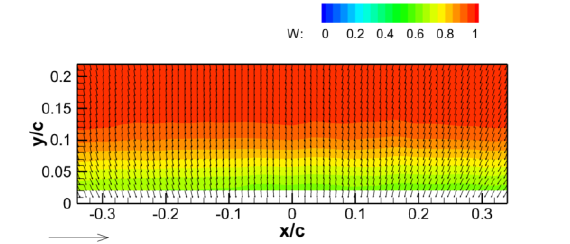
Fig. 3. Mean velocity components distribution, measuring plane 1 .